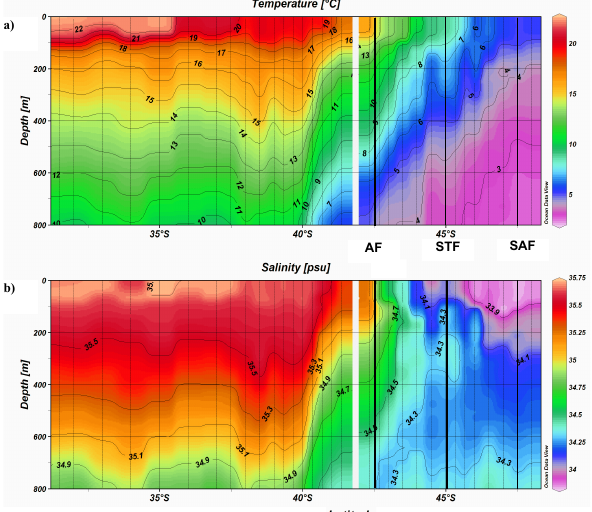
Fig. 3. CTD sections to 800m of (a) temperature ( ◦ C) and (b) salin- ity for the Southbound Transect between 31 ◦ S and the Prince Ed- ward Islands, data points for all CTD stations are marked and ap- pear as vertical lines on the temperature section. The position of the Agulhas Front (AF), Subtropical Front (STF) and Subantarctic Front (SAF) are marked as bold vertical lines. The white space rep- resents a data gap in the CTD transect. Plots made using Ocean Data View (Schlitzer, 2002).